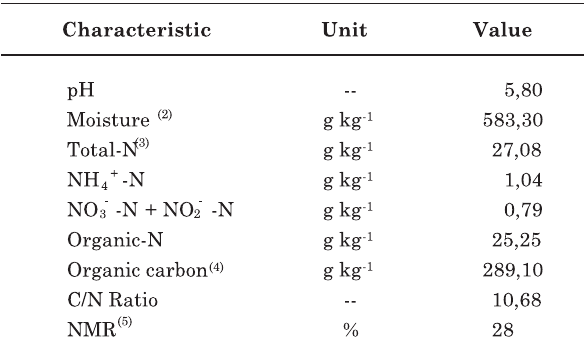
Table 1. Some chemical (1) properties of sewage sludge applied to